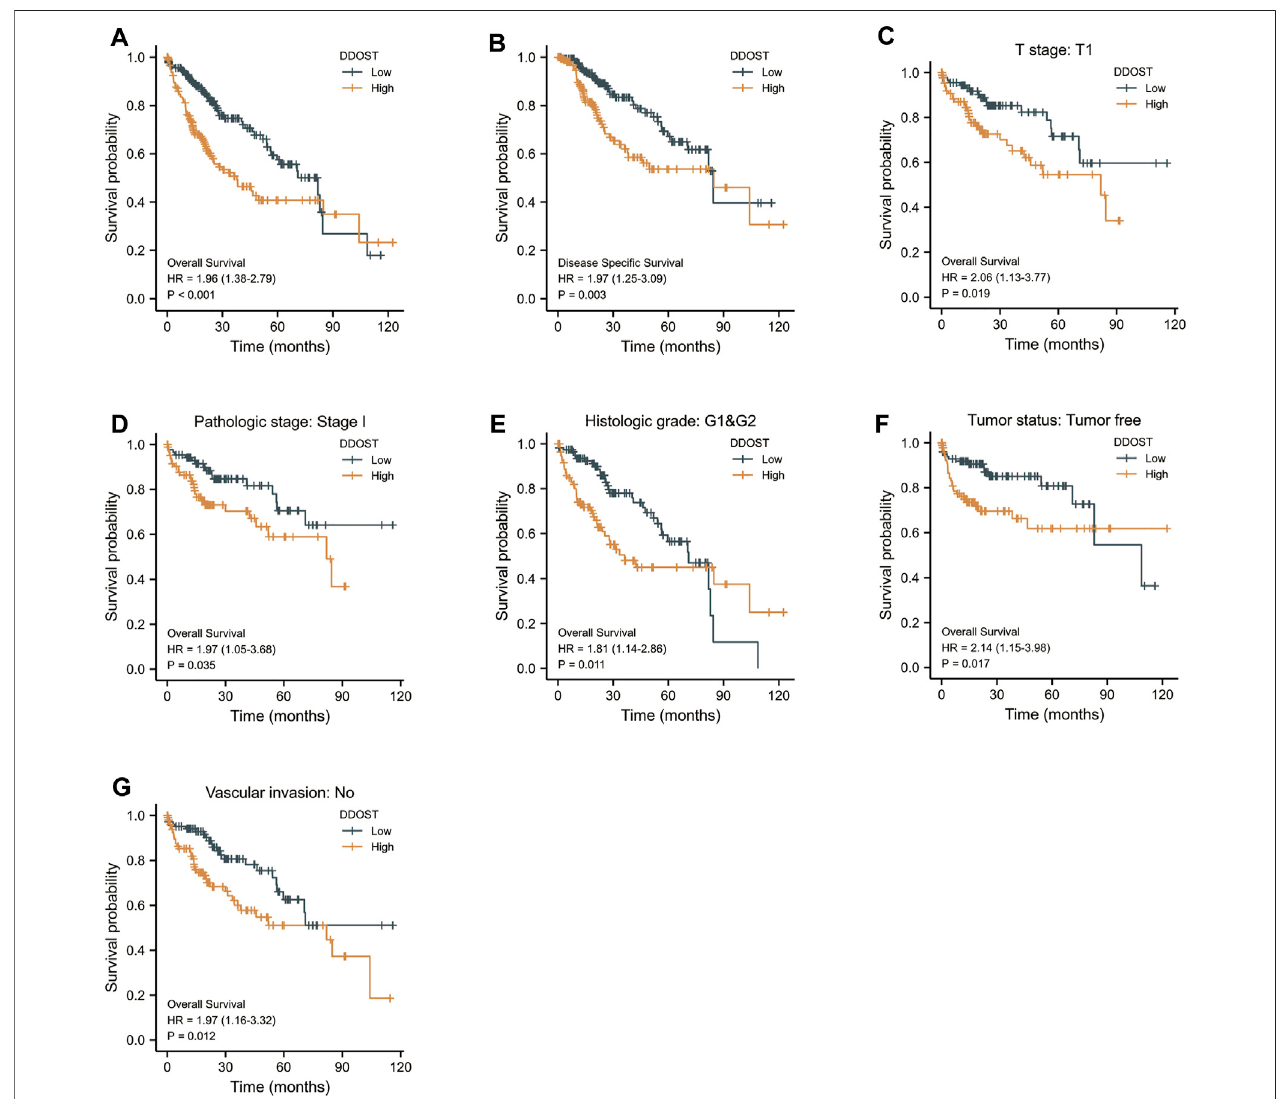
FIGURE 6 | The prognostic value of DDOST in the different subgroups. (A,B) The prognostic value of DDOST in OS and DSS of HCC. (C – G) High expression of DDOST was associated with worse OS in different subgroups.